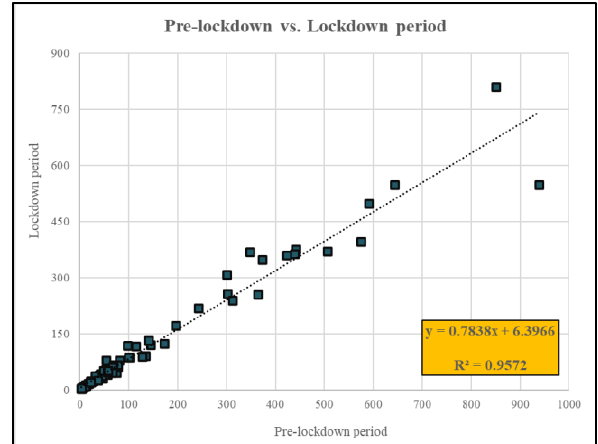
Figure 15. Correlation Between lockdown and pre- lockdown